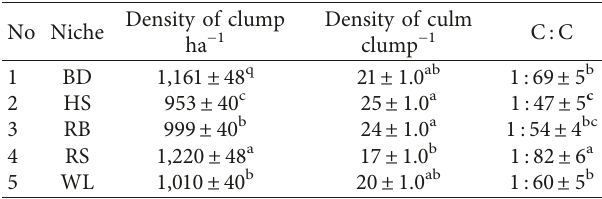
Figure 6: Diameter age relationship of bamboo culms (BD � boundary; HS � homestead; RB � river bank; RS � roadside; WL � woodlot plantation niches). Table 2: Clump characteristics of bamboo culms (mean standard ±